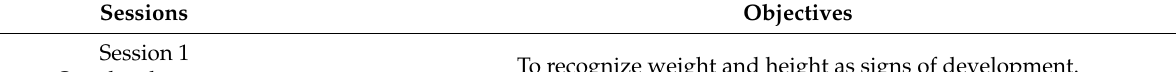
Table 1. “PREVIENE-C Á DIZ” [CADIZ-PREVENT] intervention sessions aimed at schoolchildren. Sessions Objectives Session